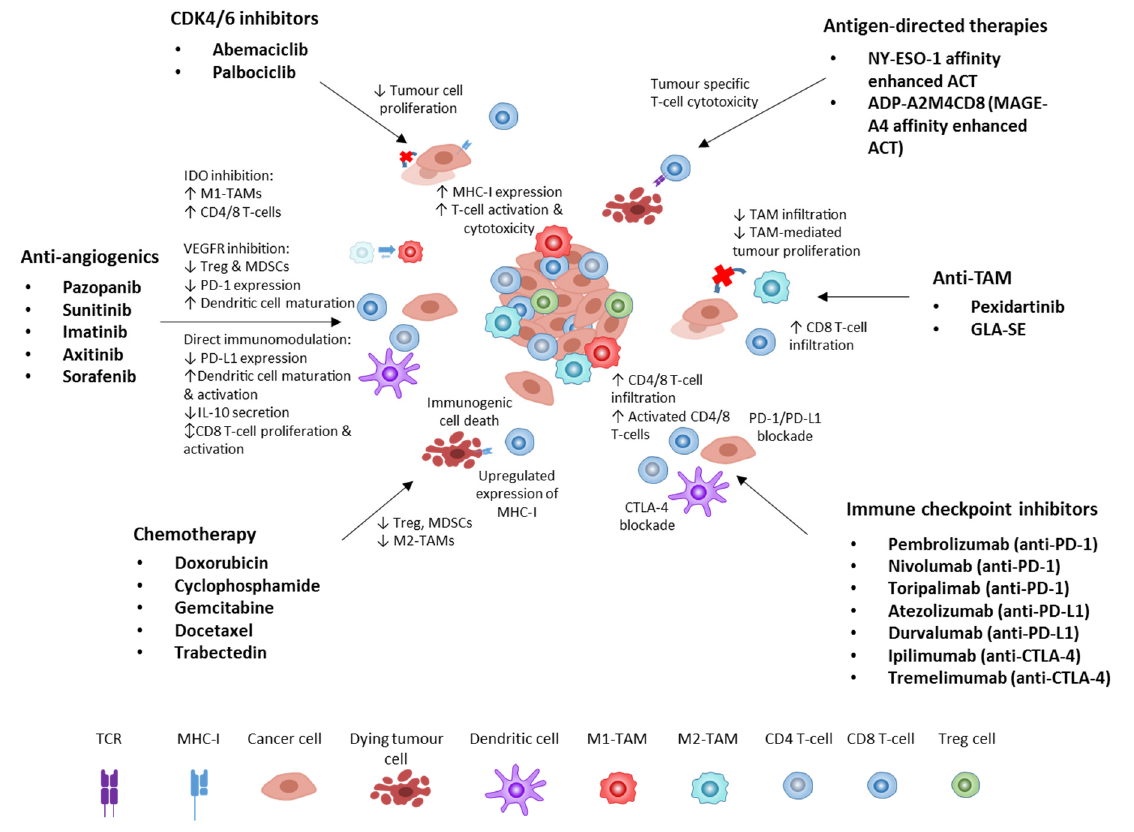
Figure 1. Overview of immunomodulatory agents under preclinical or clinical assessment for STS.